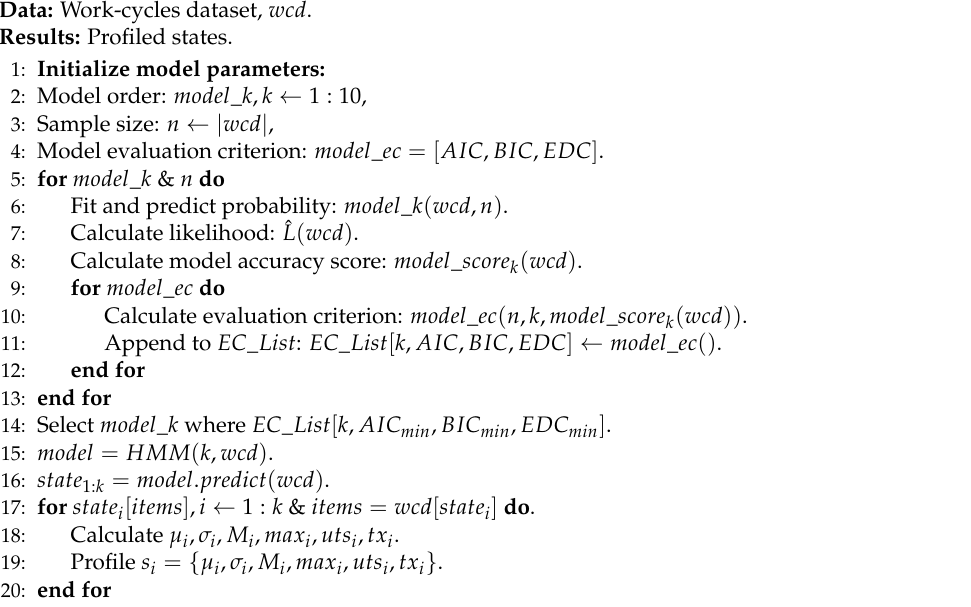
Algorithm 2 State modeling and